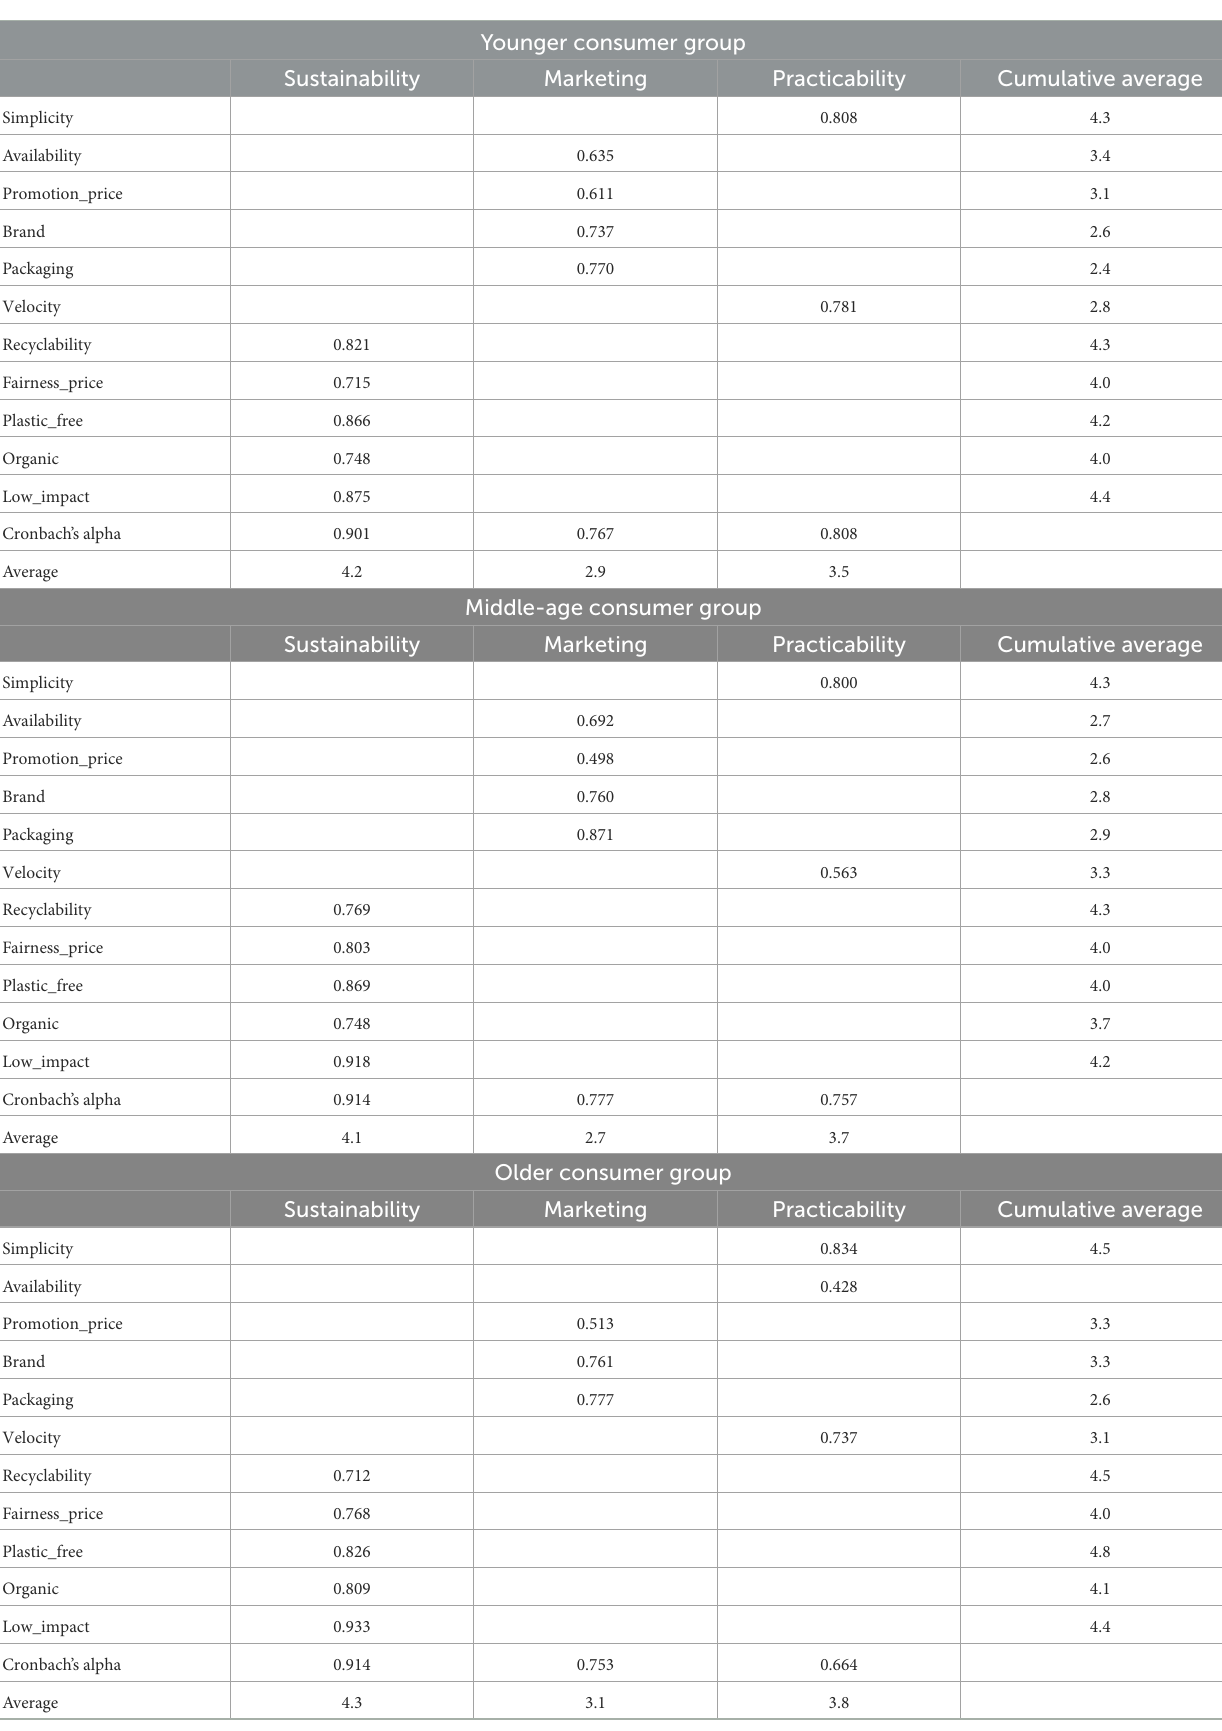
TABLE 2 Explorative factor analysis for each consumers’